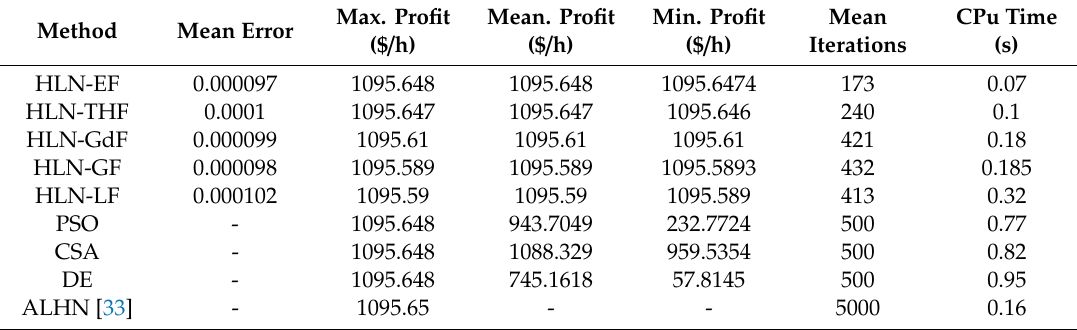
Table 2. Comparison of results obtained for three-unit system with the second revenue